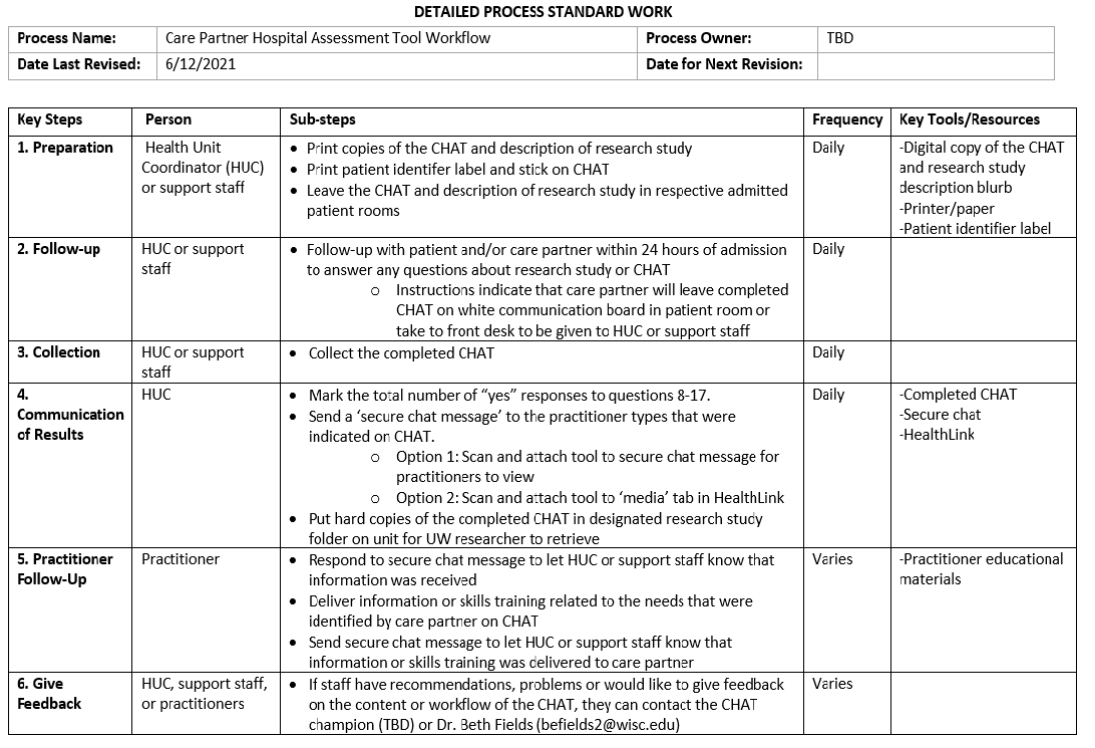
Figure 1. Example workflow for CHAT implementation at UW Health